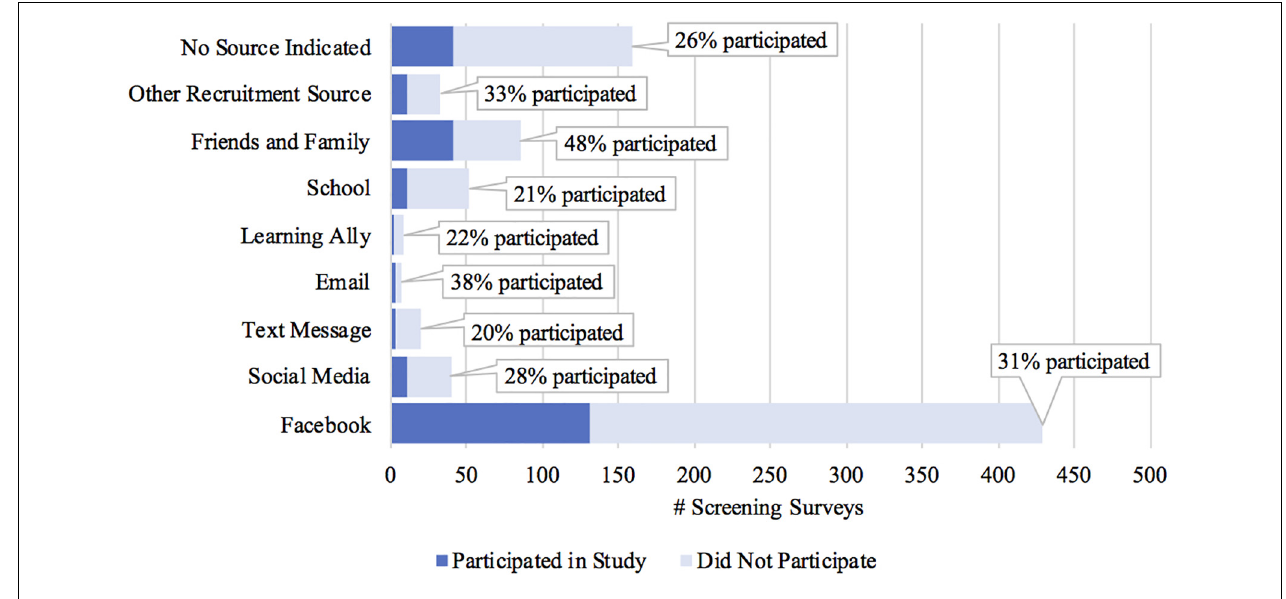
FIGURE 3 | Completed screening surveys and final participants by recruiting source. TABLE 2 | Effectiveness for three representative Facebook Ad